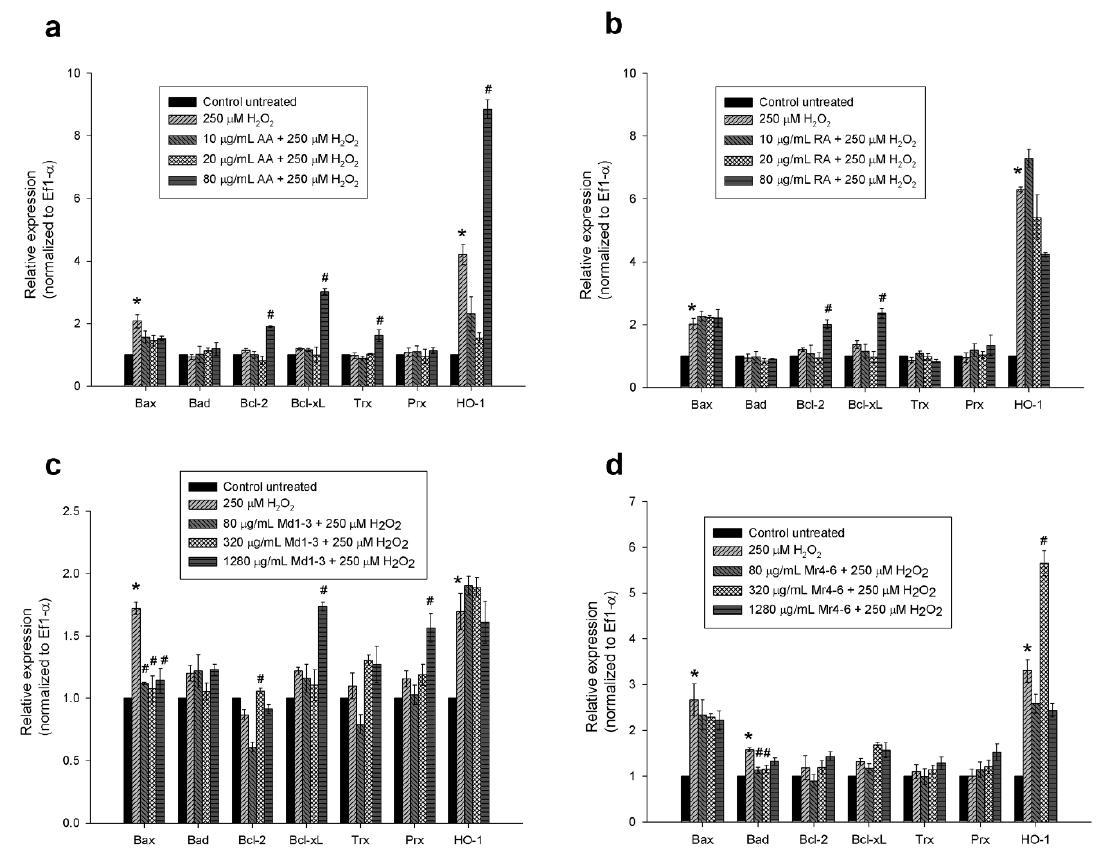
Figure 4. Effect of different concentrations of ( a ) ascorbic acid; ( b ) rosmarinic acid; ( c ) M. diemenica and ( d ) M. requienii on the mRNA expression of Bax, Bad, Bcl-2, Bcl-xL, thioredoxin, peroxiredoxin-I and heme oxygenase-1 in H 2 O 2 -induced damage in SH-SY5Y cells. Results are presented as mean ± standard error (SE) ( n = 3). * indicates that treatment with H 2 O 2 is significantly different ( p < 0.05) from control untreated cells within a single gene, # indicates that pretreatment with mint extracts, AA or RA is significantly di ff erent ( p < 0.05) from H 2 O 2 -treated cells within a single gene. AA: ascorbic acid, RA: rosmarinic acid, Md1-3: Mentha diemenica , Mr4-6: M. requienii , Trx: thioredoxin, Prx: